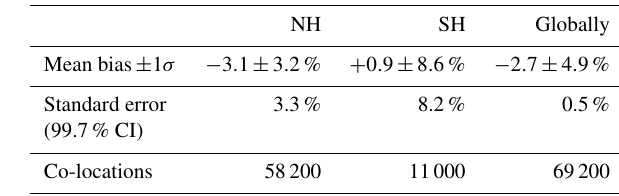
Table 1. The monthly mean global and hemispheric statistics of the co-located satellite- and ground-based